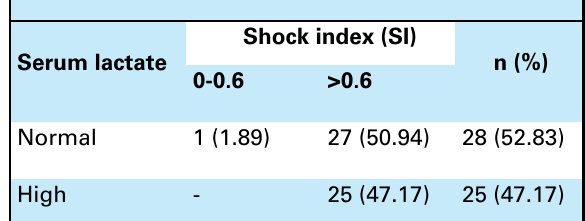
Table 4. Shock Index in patients with normal and high lactate levels (n=